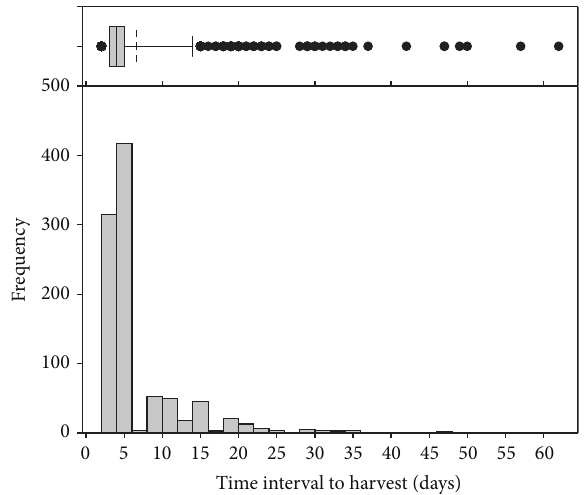
Figure 6: Frequency distribution of predator harvest intervals. Box plot (top): bars represent 25% and 75% quartiles, line between bars represents the median, dashed line represents the mean, bracket represents the 90% percentile, and dots represent outliers. Bar plot (bottom): bars represent 2-unit